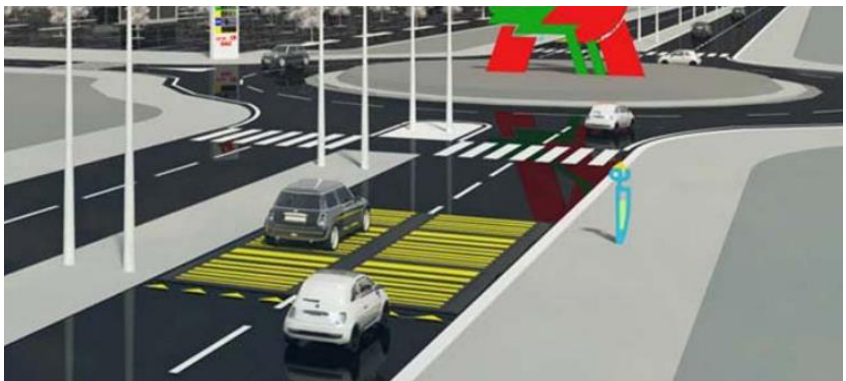
Figure 2. Artificial road roughness system for battery roads [8].